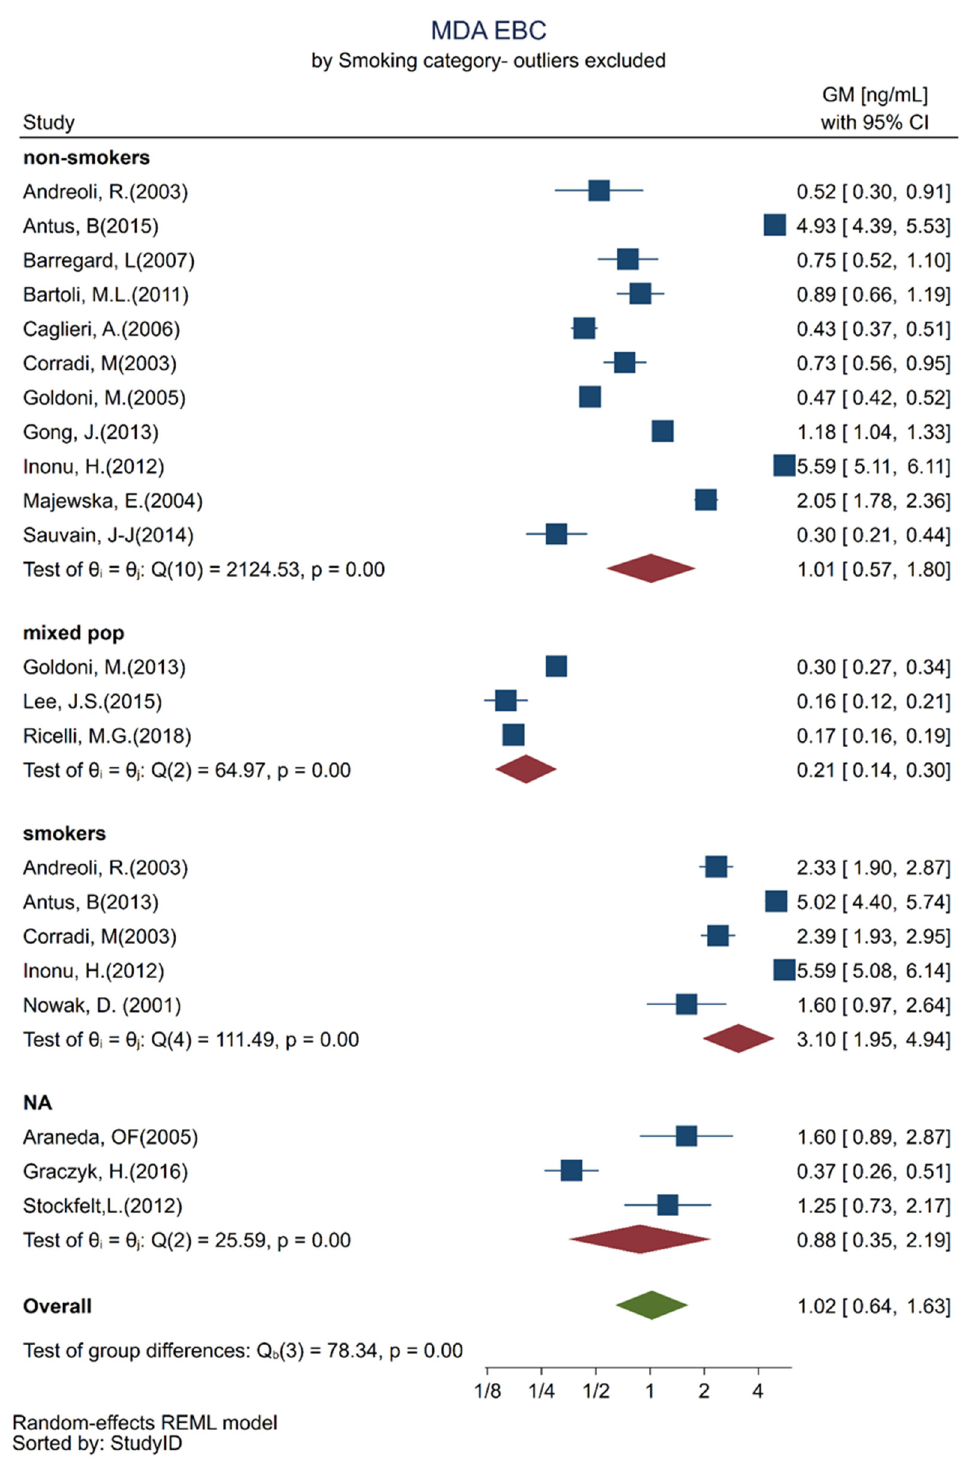
Figure 4. Forest plots of MDA in EBC concentration quantified in healthy adult participants consid- ering their smoking habits: non-smokers exclusively [24,25,31,32,34,36,42,43,46,50,58]; mixed popu- lation of smokers and non-smokers [41,49,55], smokers exclusively [24,26,36,46,51] and unknown smoking status [28,44,59].